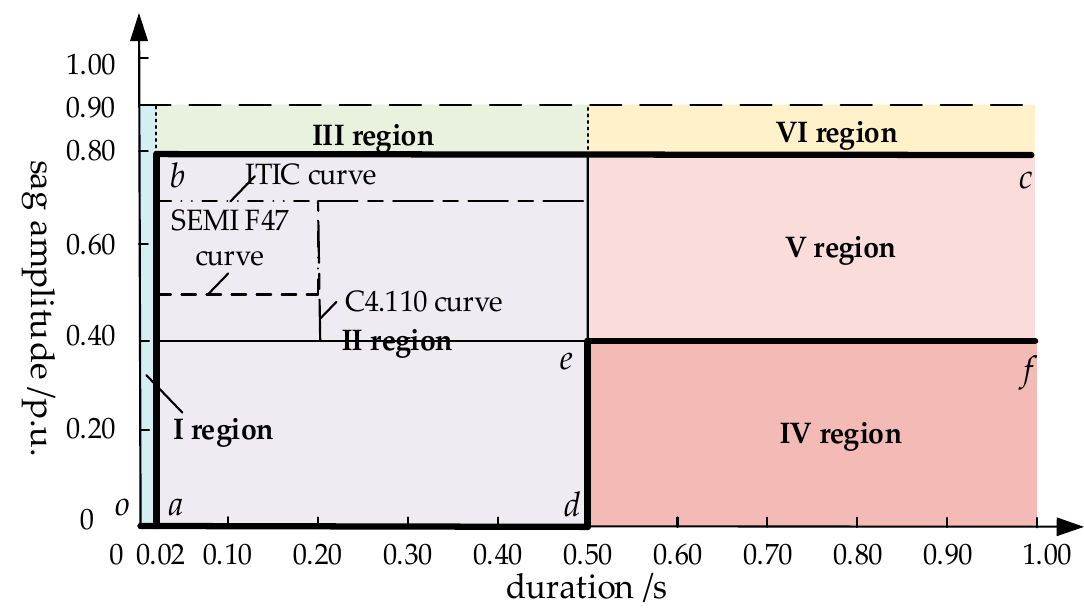
Figure 2. User voltage tolerance curve.